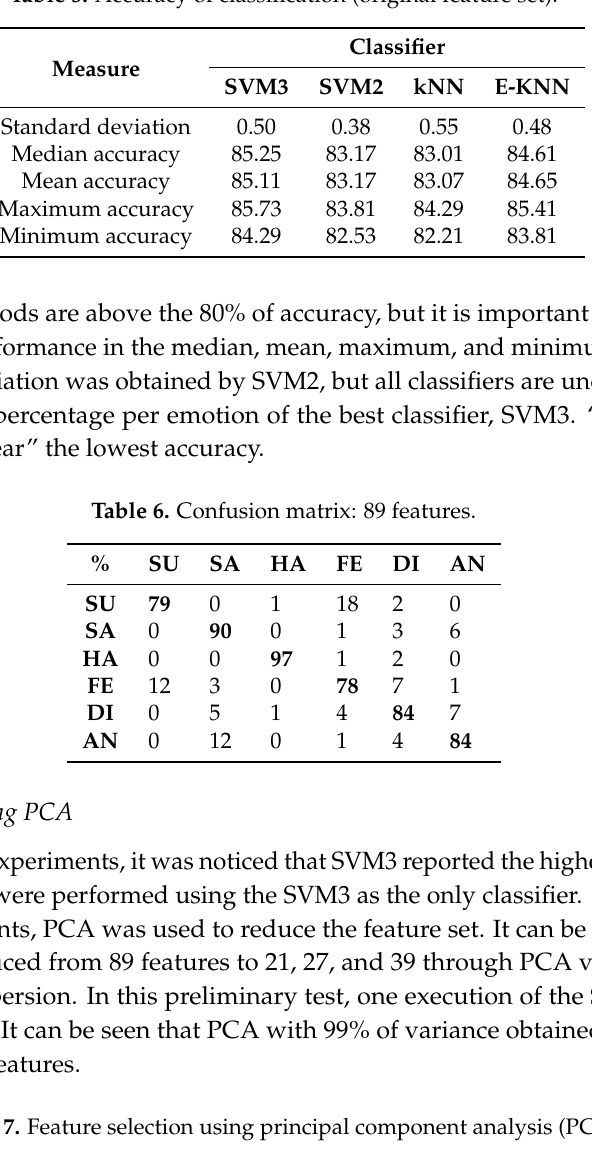
Table 5. Accuracy of classification (original feature set).